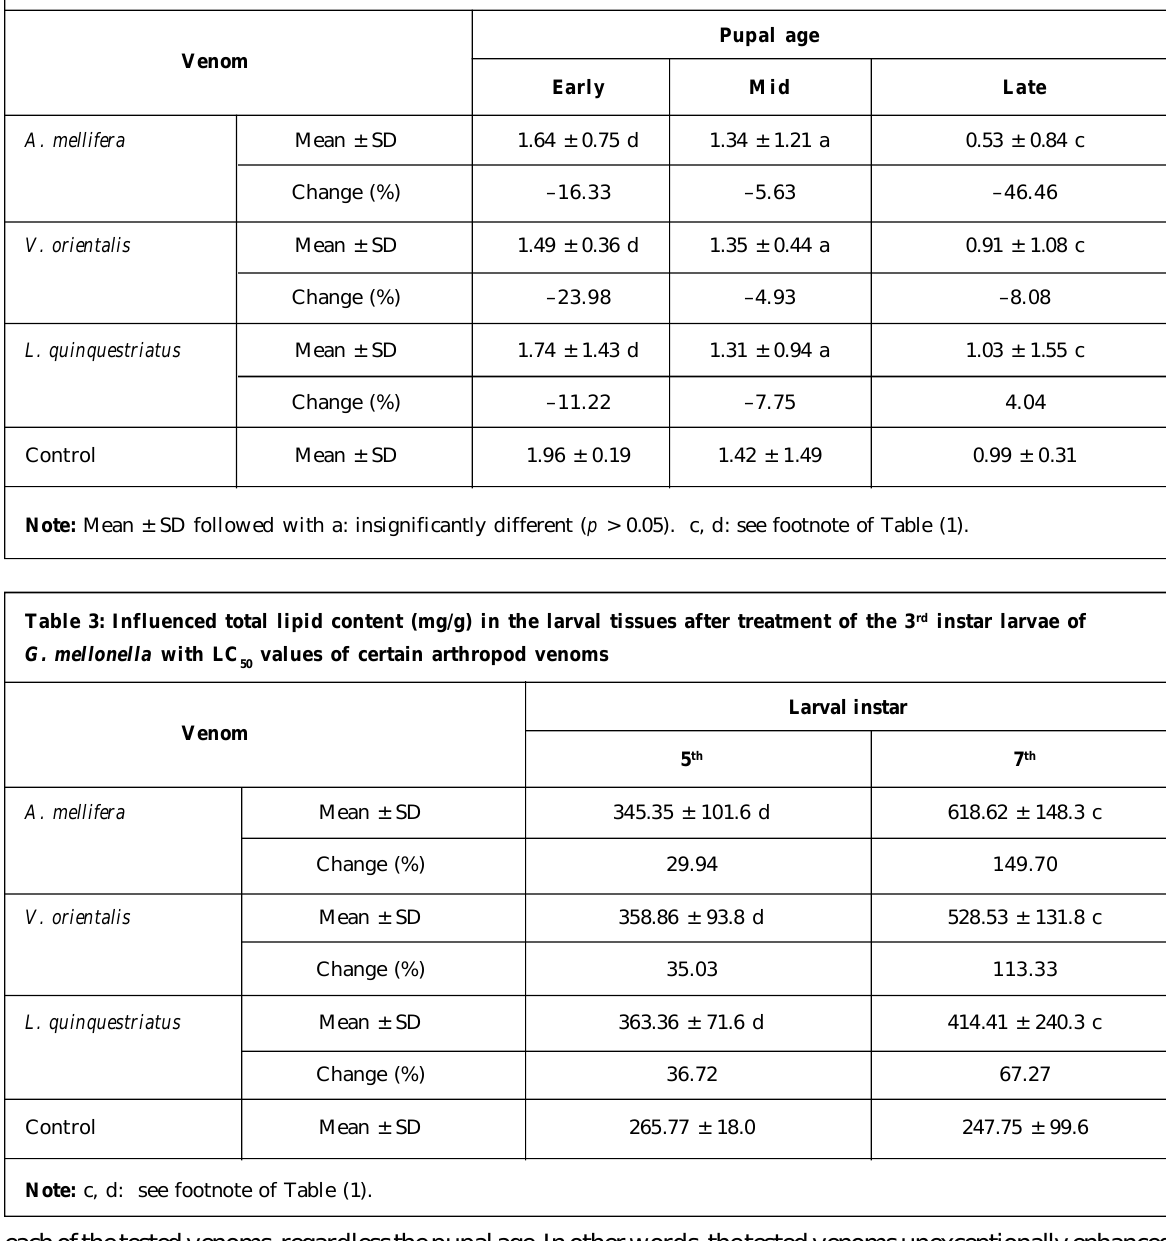
Table 2: Influenced total protein content (mg/g) in the pupal tissues after treatment of the 3 rd instar larvae of values of certain arthropod G. mellonella with LC 50